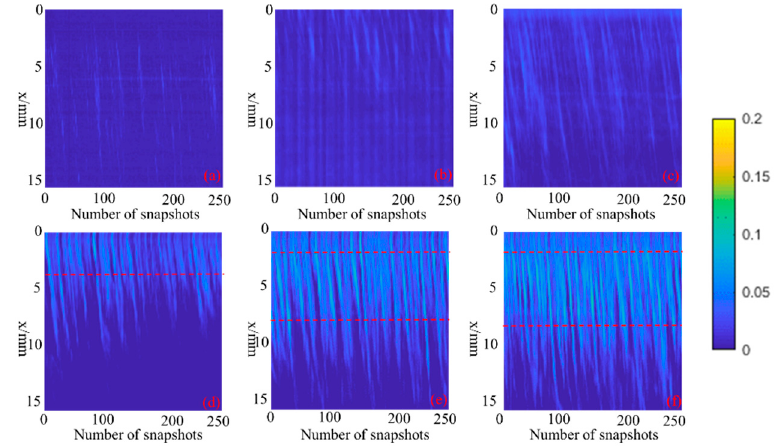
Figure 9. Position-time diagram of cavitation ( a ) Hydrodynamic cavitation, inlet pressure 1.5 MPa. ( b ) Hydrodynamic-Acoustic Cavitation, inlet pressure 1.5 MPa, transducer electric power 250 W. ( c ) Hydrodynamic-Acoustic Cavitation, inlet pressure 1.5 MPa, transducer electric power 500 W. ( d ) Hydrodynamic cavitation, inlet pressure 2 MPa. ( e ) Hydrodynamic-Acoustic Cavitation, inlet pressure 2 MPa, transducer electric power 250 W. ( f ) Hydrodynamic-Acoustic Cavitation, inlet pressure 2 MPa, transducer electric power 500